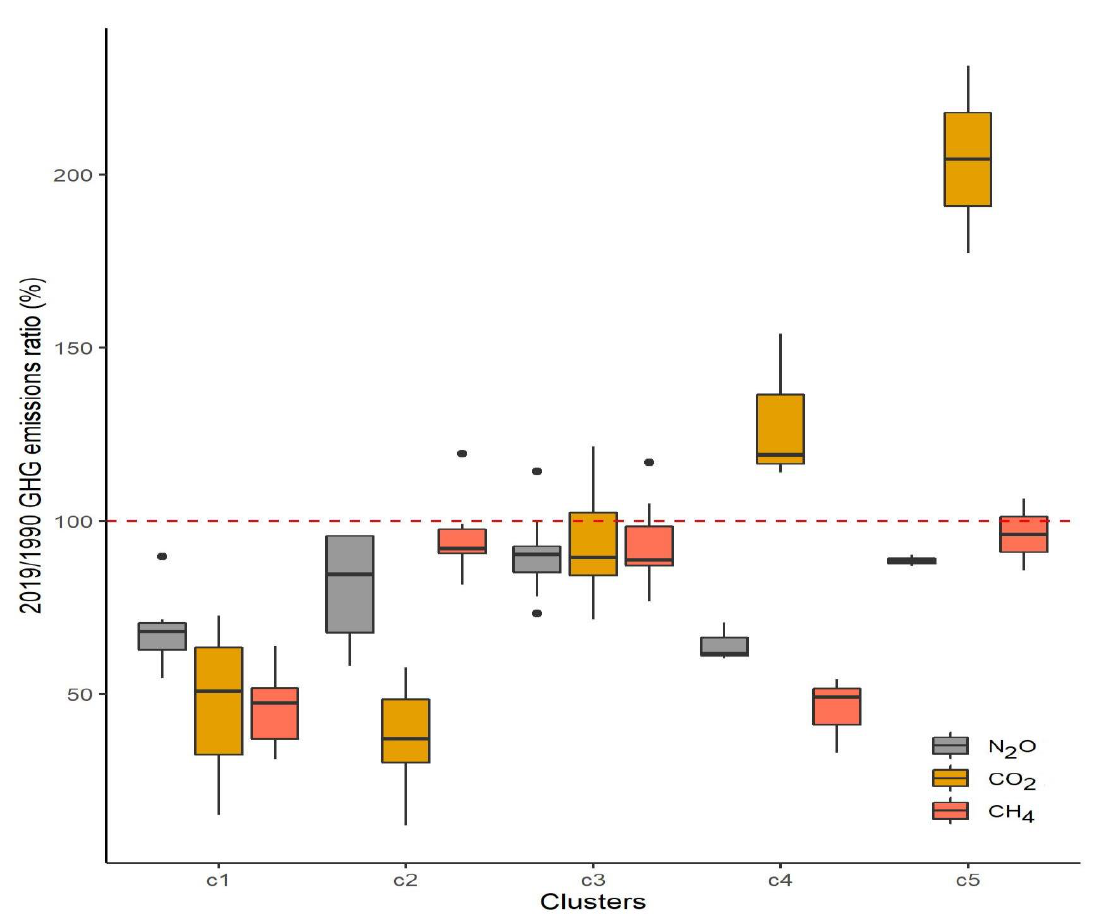
Figure 7. Ratio of GHG emissions 2019/1990 (dashed line indicates no change, below the line changes were negative, above the line they were positive; C1 – C5: clusters of countries indicated by Figure 6.